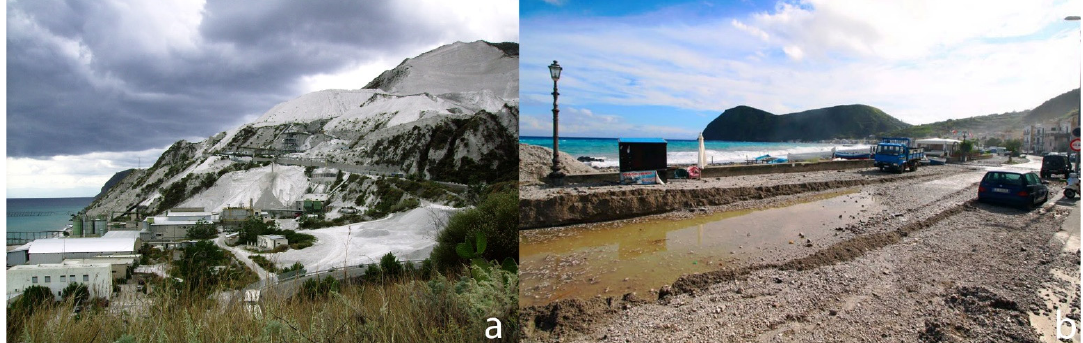
Figure A9. ( a ) The pumice exploitation plants at Porticello in the 1960s and 1970s (from https://upload.wikimedia.org/wikipedia/commons/9/94/Lipari_-_La_pomice_-_panoramio.jpg, accessed on 20 June 2022); ( b ) flash flooding of the Calandra creek in the northern Canneto beach.